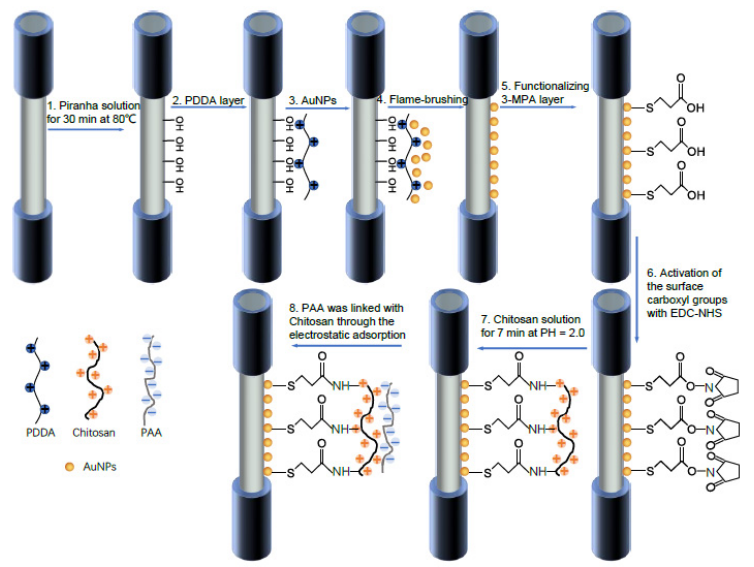
Figure 14. A summary scheme for the functionalization of the optical fiber in order to obtain the LSPR sensor. Reprinted with permission of [61].